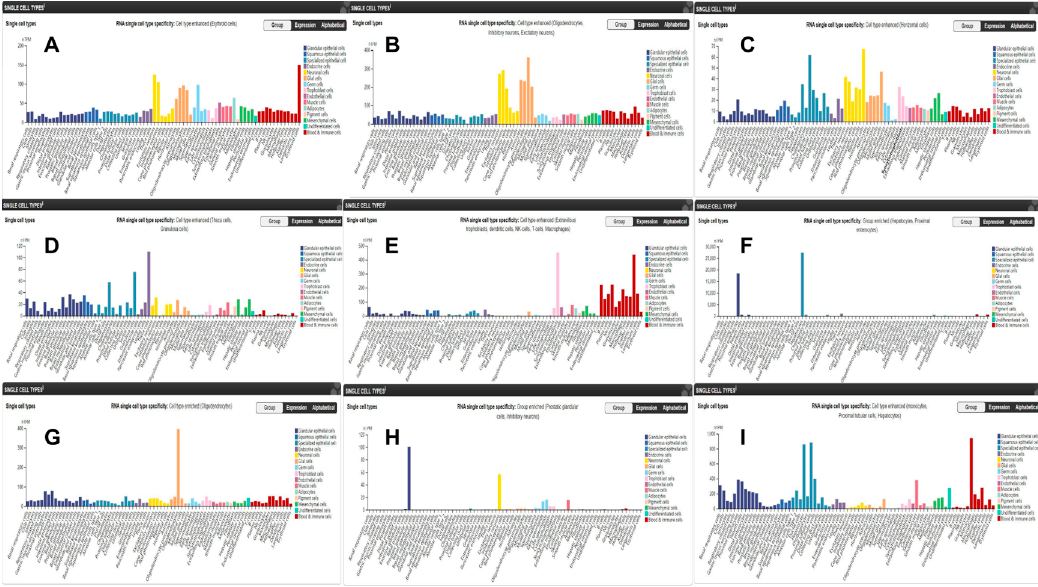
Figure 8. Hub gene expression in human tissues. ( A ) LNX2; ( B ) BIRC6; ( C ) ANKRD46; ( D ) IRS1; ( E ) TGFB1; ( F ) APOA1; ( G ) PSEN1; ( H ) NPY; ( I )